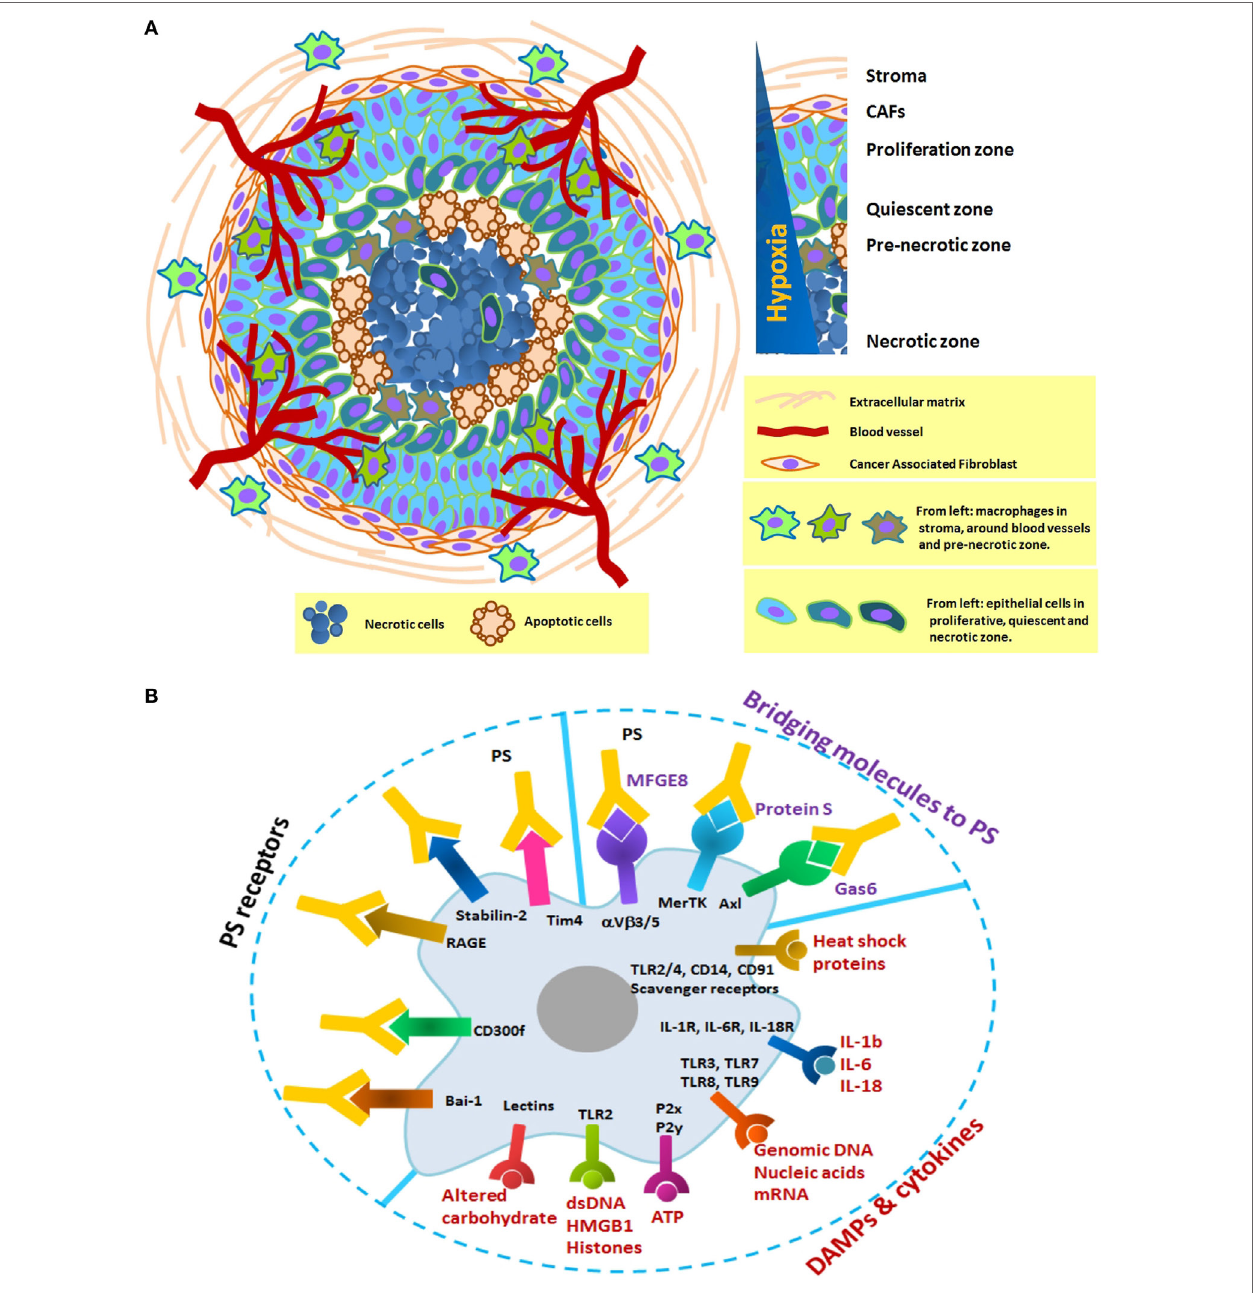
FigUre 1 | (A) Schematic formation of a distinct necrotic zone in carcinoma and immobilization of macrophages in three distinct areas: the stroma, the vicinity of blood vessels, and the pre-necrotic zone. Tumor macrophages originate from tissue-resident cells or blood monocytes and adapt to perform a specific function depends on their local microenvironment. In hypoxia, they progressively change from M1 to M2-like phenotype with poor antigen presentation and increase in number as tumor grows. Their receptors in this zone are continuously engaged with necrotic debris and apoptotic cells. There is, therefore, a definite need to look at the prolonged changes in the phagocytic machinery of macrophages. (B) Selected macrophage receptors that potentially mediate recognition of damage- associated molecular patterns (DAMPs), cytokines, and PS in the necrotic zone. DAMPs and cytokines can activate macrophages through the multiple surface receptors. Exposed PS on the surface of necrotic debris or apoptotic cells can be recognized directly by PS receptors (Bai-1, Tim4, etc.) or indirectly by bridging molecules (Gas6, protein S, and MFGE8).